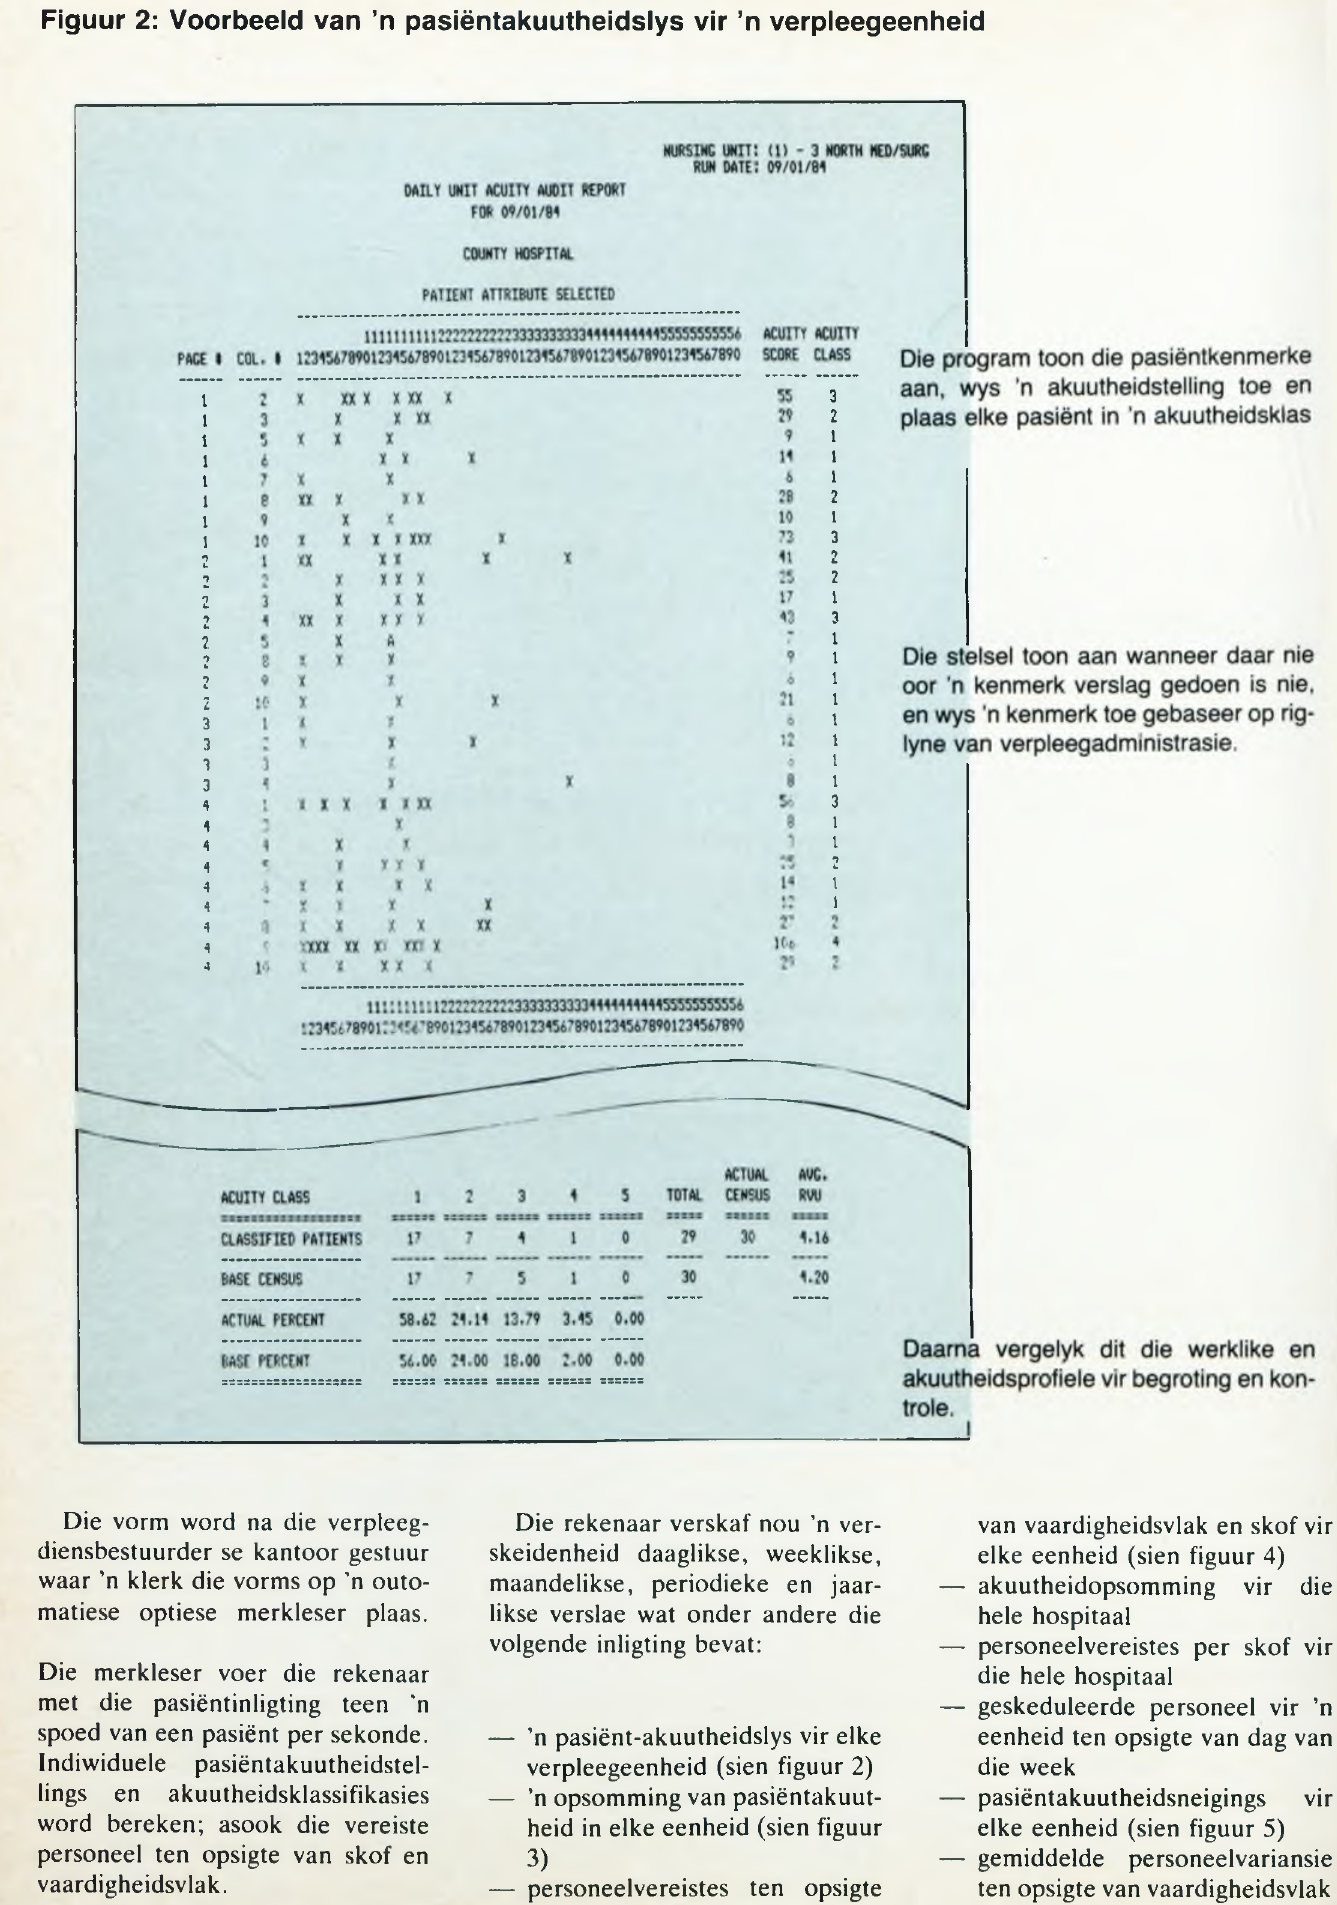
Figuur 2: Voorbeeld van ’n pasiëntakuutheidslys vir ’n verpleegeenheid